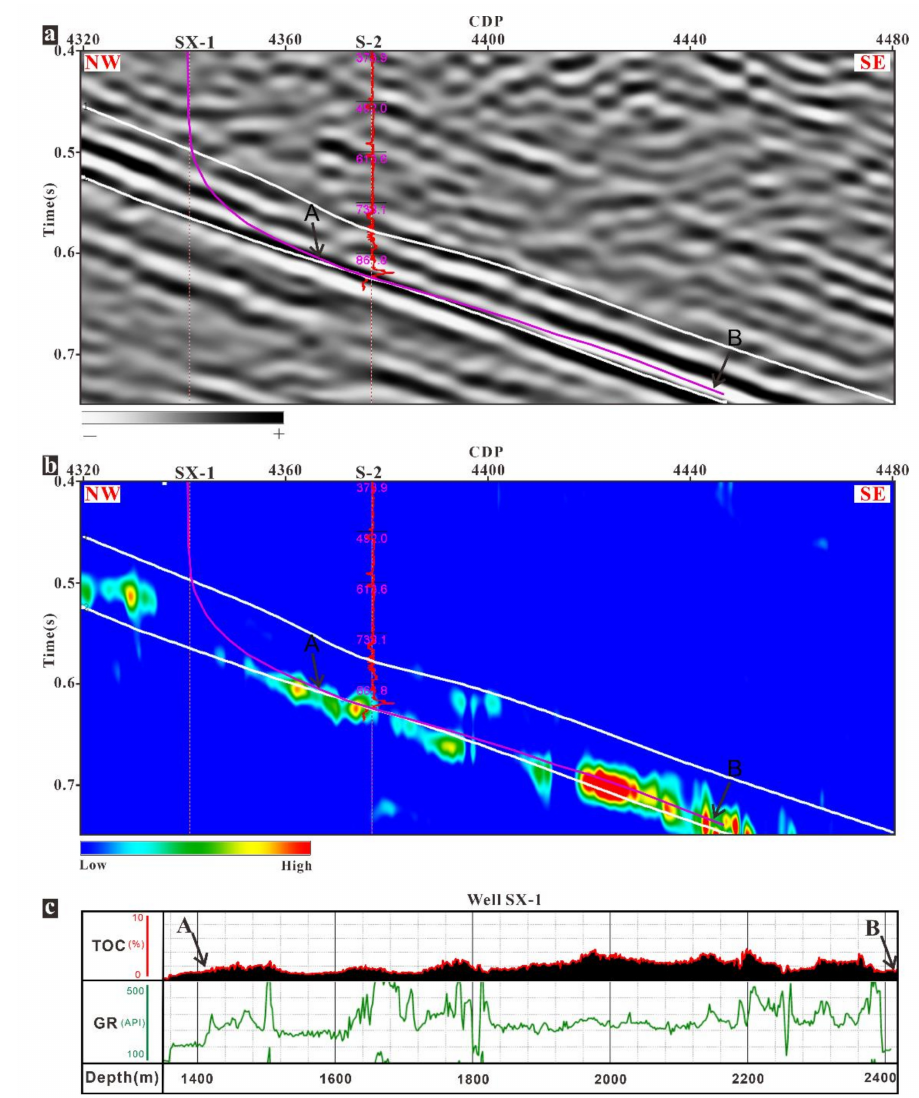
Figure 10. Seismic amplitude section ( a ), seismic fluid mobility section ( b ) connecting gas wells SX-1 and S-2, and logging data in the horizontal section (A–B) of deviated well SX-1 ( c ). In panel ( a , b ), NW and SE, respectively, denote the northwest and southeast direction of the study area, the two white lines are the top and bottom interfaces of Longmaxi Formation, the red curve near well S-2 is the GR logging curve, the pink scale near well S-2 is the vertical depth (m), and the pink line is the trajectory of deviated well SX-1. The cold and warm colors in panel ( b ) correspond to the low and high gas-bearing properties in Longmaxi